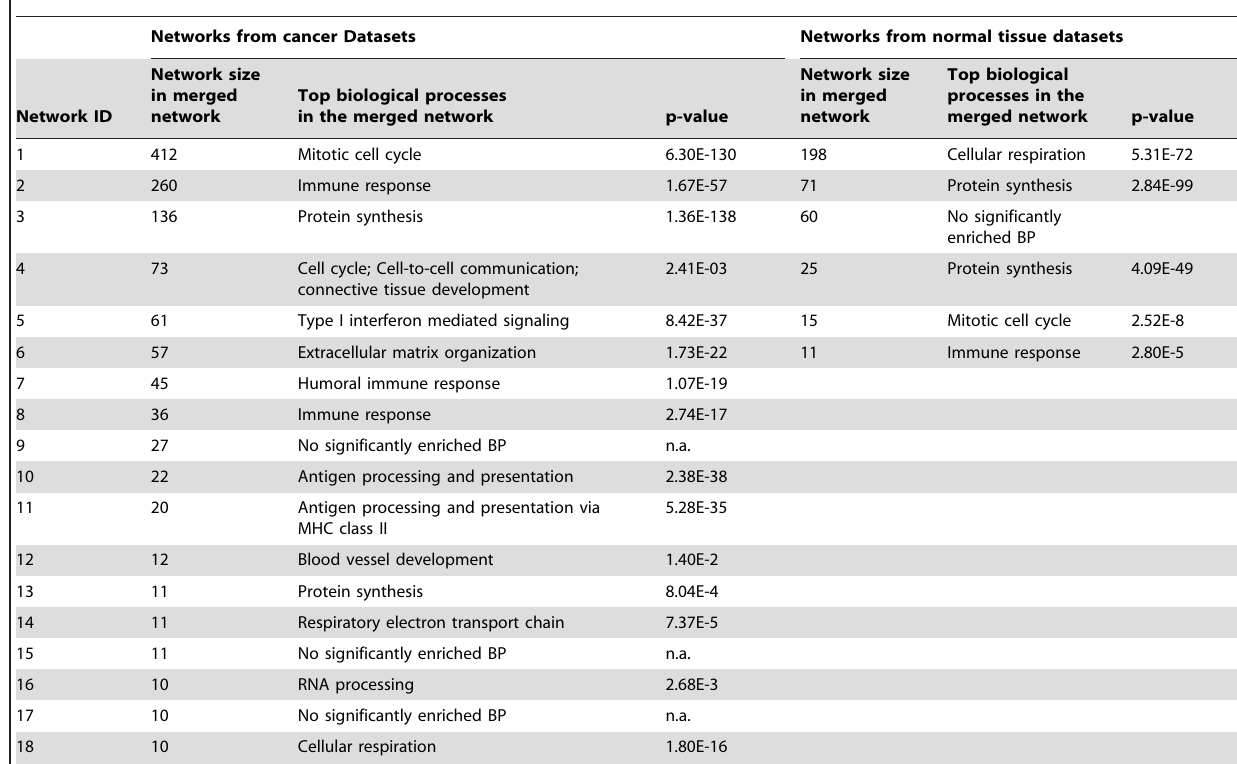
Table 2. Summary of co-expression networks identified from multiple cancer datasets vs. normal tissue datasets.